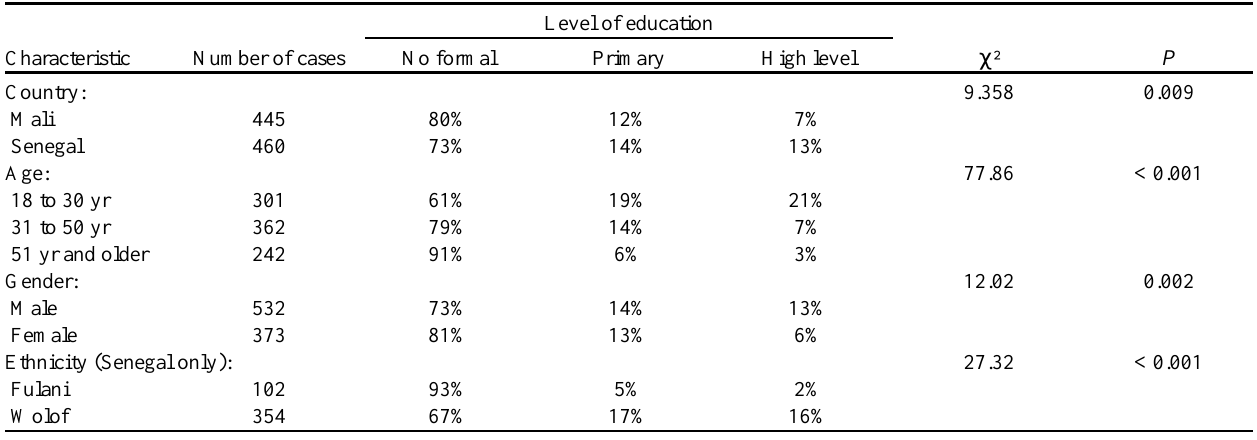
Table 1. Respondents’ level of formal education by country, age, gender, and ethnicity.